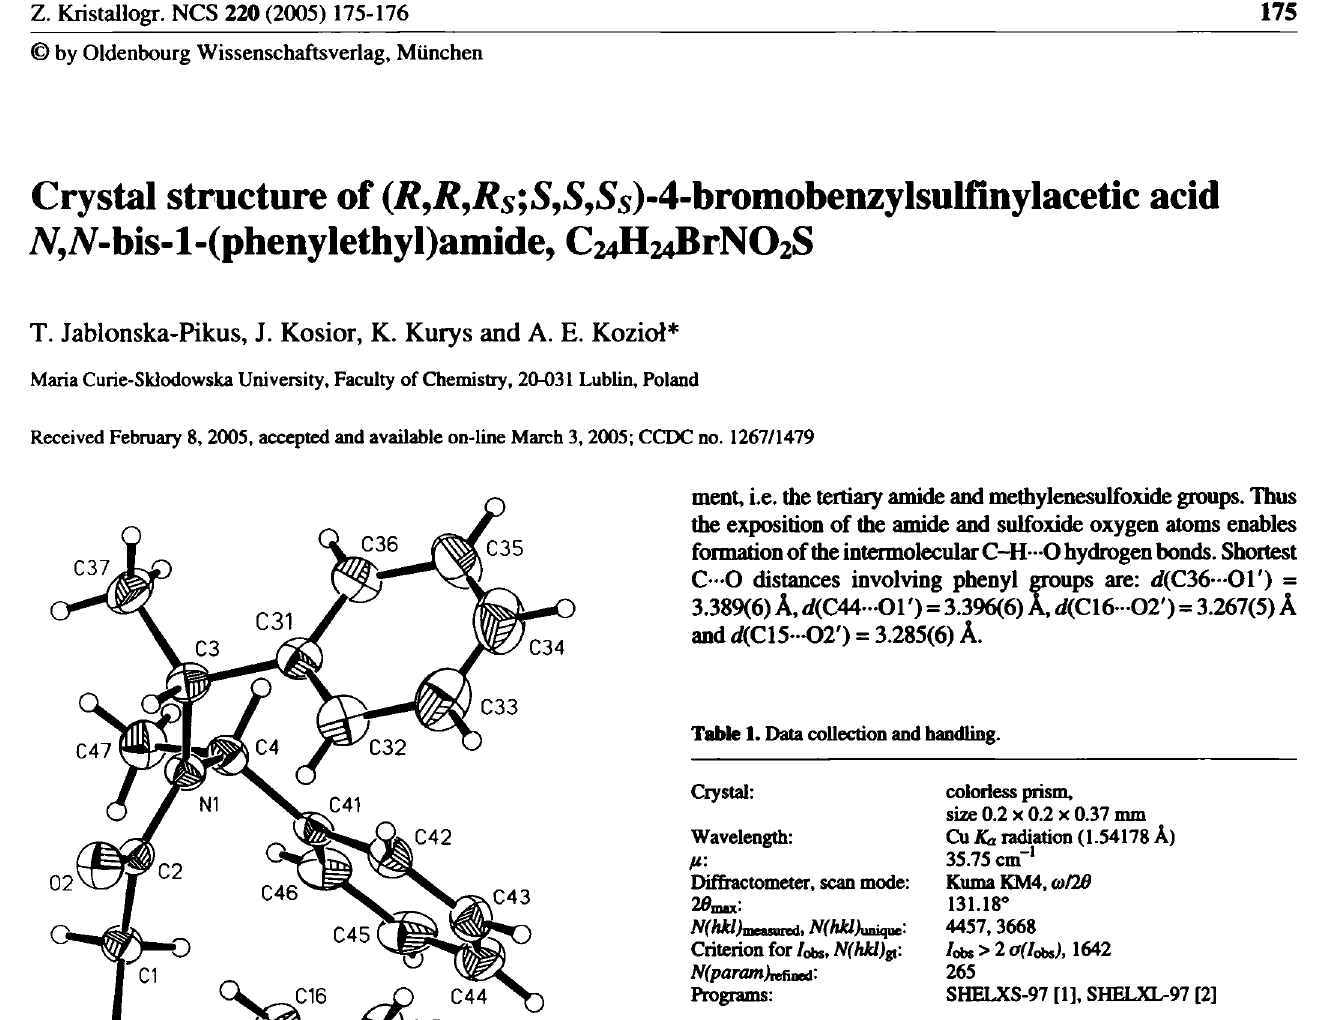
Table 2. Atomic coordinates and displacement parameters (in A 2